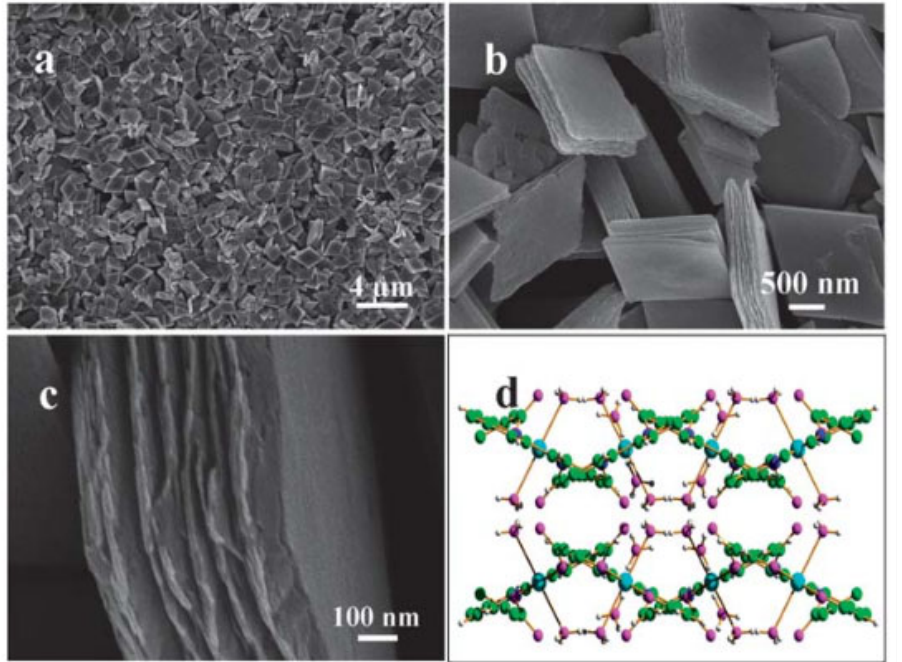
Figure 15. ( a – c ) SEM images of different morphologies and ( d ) crystal structure of Cu-based coordi- nation polymer reported by Tynan et al. Reproduced with permission from [99] .